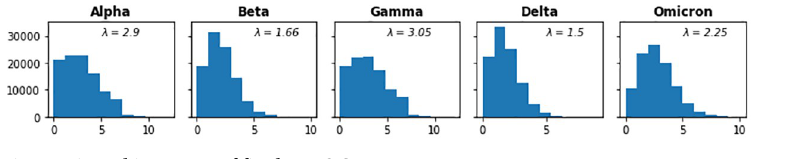
Fig 9. Poisson histograms of five key